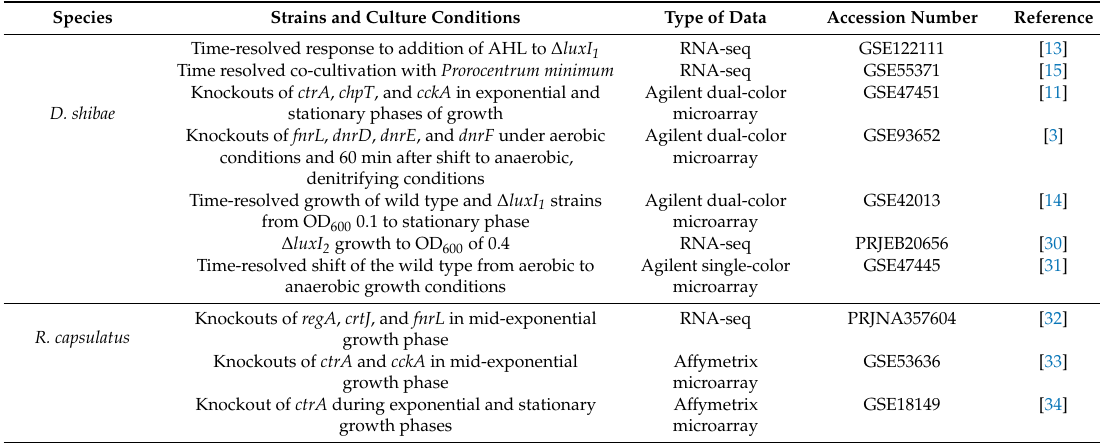
Table 1. Description of the transcriptomic datasets analyzed in this